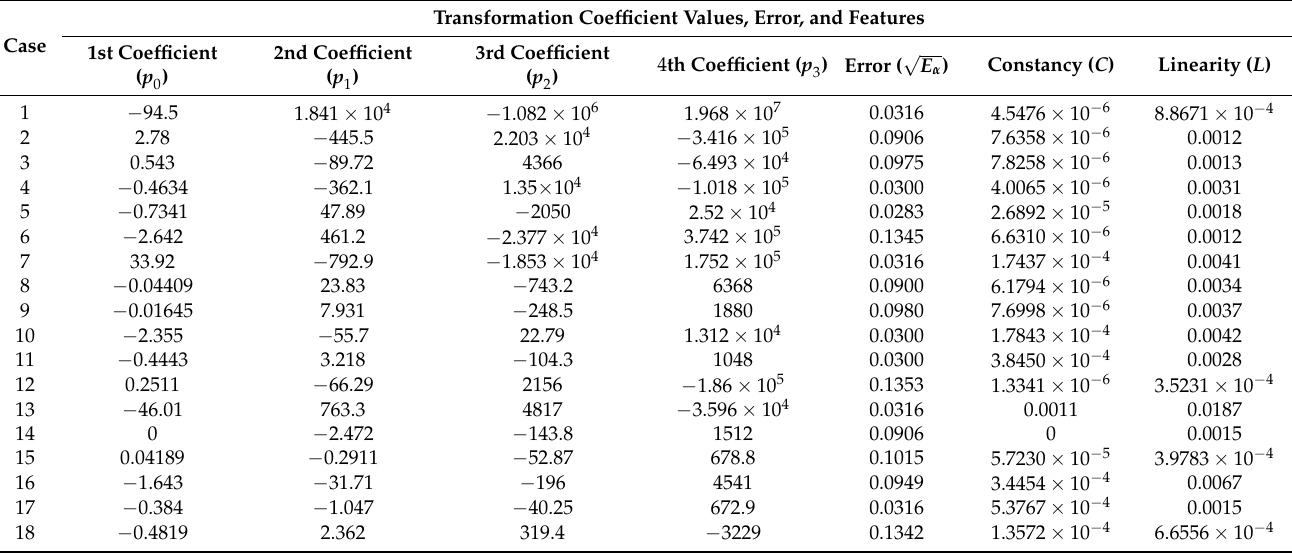
Table 2. Values of the transformation coefficients, error, and features for each